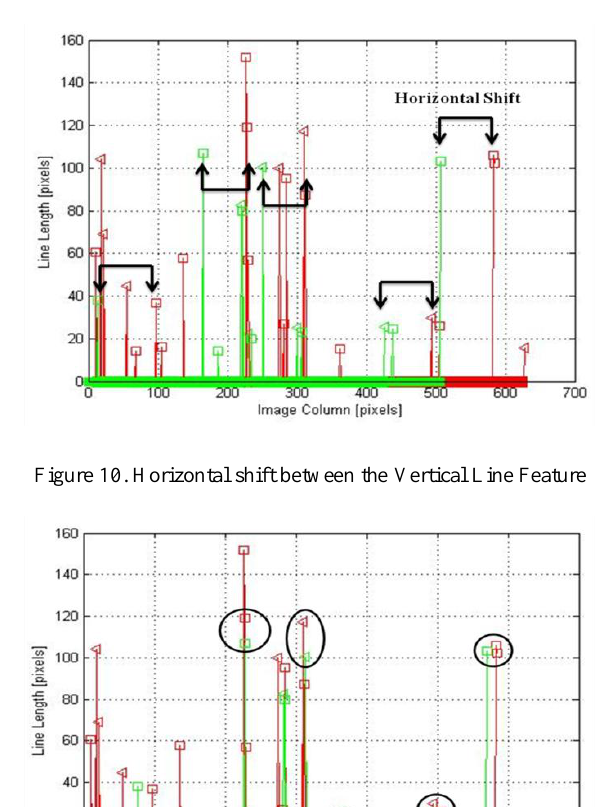
To identify 3D control points in the synthetic image, each georeferenced vertex of the 3D model is assigned an RGB colour. By extracting the colour of a vertex in the synthetic image, the 3D georeferenced coordinates are obtained. As an initial approximation for the camera‟s position and orientation was available, space resection via collinearity was performed for both the video frame and synthetic image, the results are provided in Table 1.